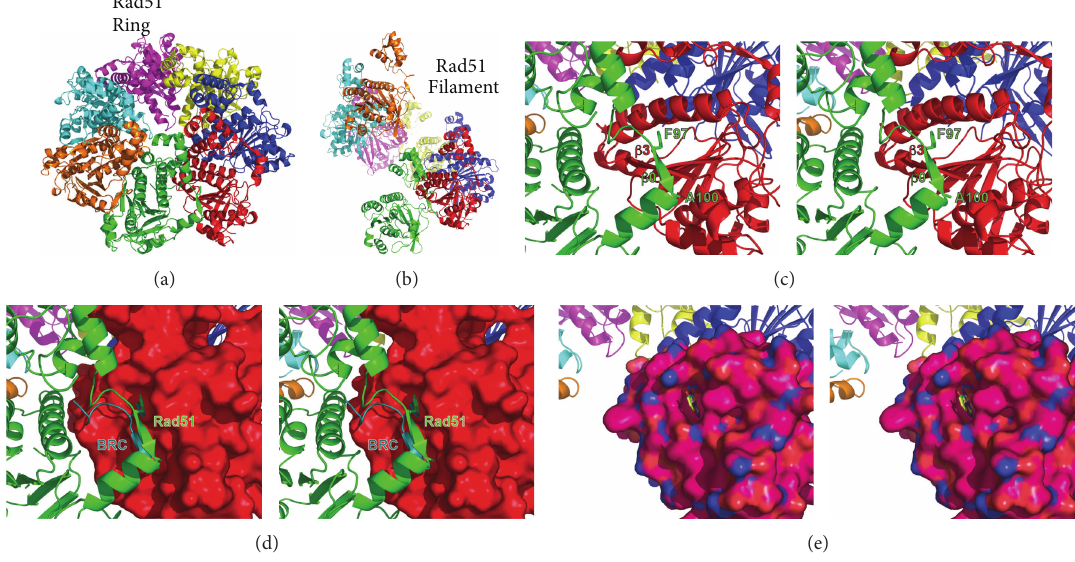
Figure 8: Rad51 assemblies and interface mimicry and exchange. (a) A Rad51 ring model derived from a P. furiosus crystal structure is composed of 7 identical subunits, each colored differently (PDB code 1PZN). While substantial intersubunit contacts are made on both sides of each individual subunit, the interactions made by the polymerization motif (PM) shown in (c) are responsible for the ability of the assembly to transition from a ring to a filament, as shown in (b). (b) A Rad51 filament model derived from docking in a P. furiosus crystal structure into S. solfataricus Rad51 electron microscopy 3D reconstruction density. This assembly generally forms upon binding DNA to generate a nucleoprotein filament, where DNA resides in the interior of the assembly. (c) Wall-eyed-stereoview zoom of Rad51 subunits from (a). The PM resides in the interdomain linker that tethers the N-terminal and C-terminal domains together. The PM 𝛽 0 (green) extends the 𝛽 -sheet made by the adjacent subunit (red) by bonding to 𝛽 3. The conserved Phe buries itself into a pocket formed by the adjacent subunit. The conserved Ala residue also stabilizes the PM via hydrophobic interactions. (d) Same view as in (c), however the surface of the red subunit is shown.OverlayoftheHsRad51ATPase:BRC4domainfusionstructure(PDBcode1N0W)withPfRad51revealsthatBRC4mimicsinteractions made by the Rad51 PM, and it is proposed that the interfaces may be exchanged to form Rad51:BRCA2 complexes in eukarya. (e) The same PM interface is now a target for small-molecule fragment-based approaches to develop ligands that work in conjunction with radiation and genotoxic drugs used to treat cancer. Due to the conservation of the P. furiosus and human enzymes, researchers developed a humanized PfRad51 mutant (overlaid in the position of the red subunit in other panels) and identified compounds that bind to the hydrophobic pocket that is normally occupied by the PM Phe residue (PDB codes 4B33, 4B34, and 4B3C). After optimization of a designed ligand, the interaction between Rad51 and BRCA2 may be